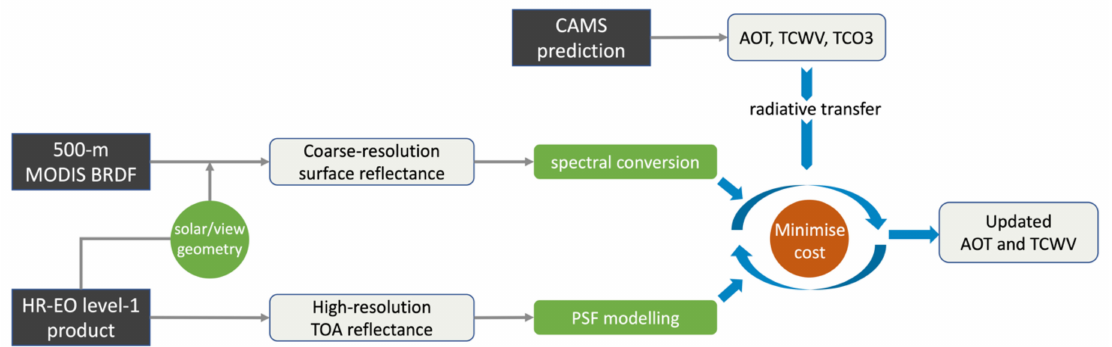
Figure 6. Flowchart of Sensor Invariant Atmospheric Correction (SIAC) processing chain to produce updated atmospheric state, which is subsequently employed to generate the surface